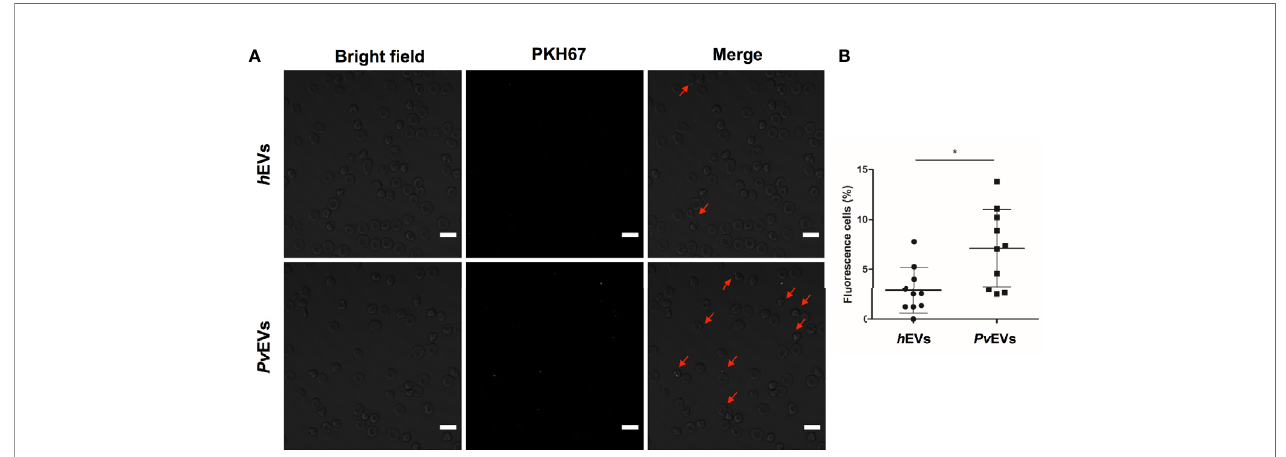
FIGURE 5 | Pv EVs and h EVs in vitro interaction with spleen mature red blood cells by confocal microscopy. (A) Puri fi ed RBCs were incubated with PKH67-labelled Pv EVs and h EVs. Confocal microscopy analysis shows RBCs with green fl uorescent dots in the membrane (red arrows). Scale bar: 10 µm. (B) Quanti fi cation of RBCs with positive staining for PKH67. Data represent the mean and standard deviation of the percentage of cells with fl uorescent green dots per fi eld (n=10) in each condition. Statistical signi fi cance (P<0.05) was assessed using unpaired and two-sided, Mann-Whitney test, *p < 0.05